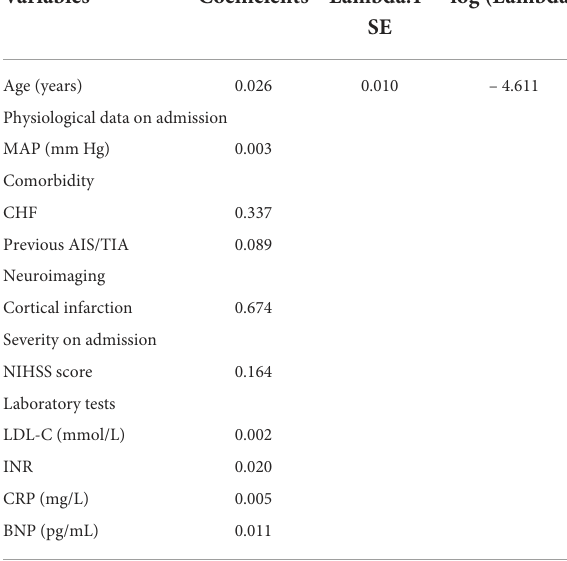
TABLE 2 LASSO regression coefficients and lambda.1-SE values in the training